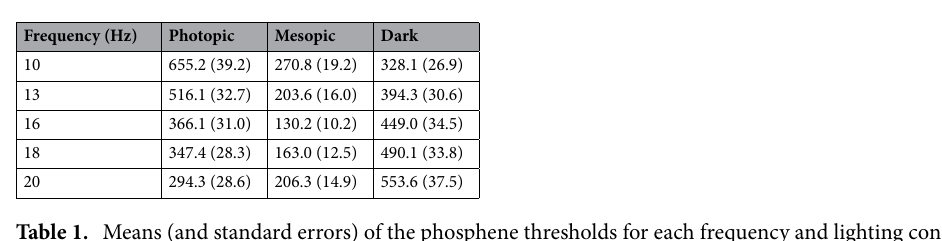
Table 1. Means (and standard errors) of the phosphene thresholds for each frequency and lighting condition tested. n = 24.